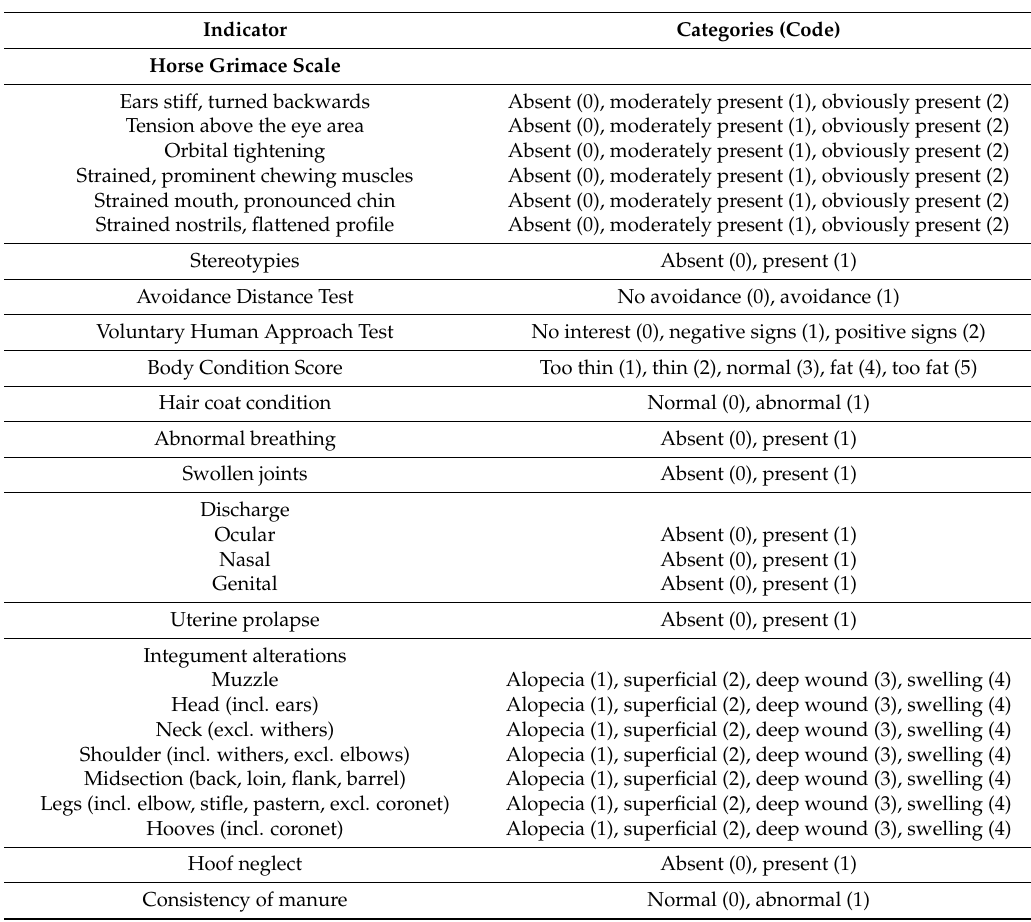
Table 1. Animal-based indicators and their respective categories of the Animal Welfare Indicators (AWIN) welfare assessment protocol for